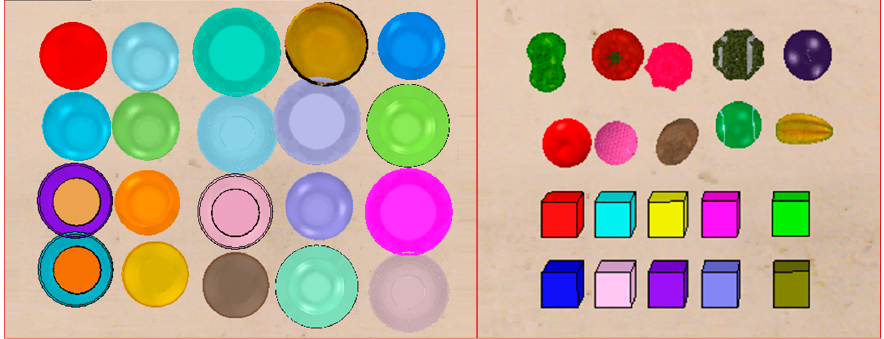
Figure 6. The objects and containers in V-REP.